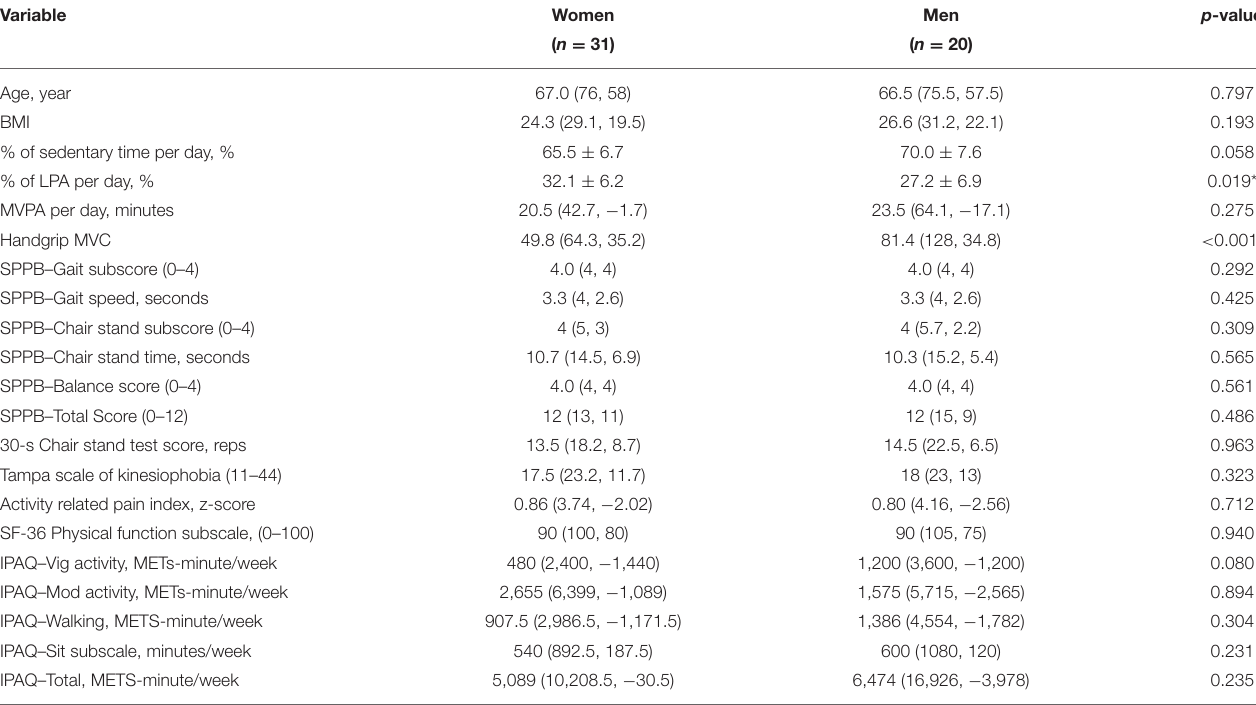
TABLE 1 | Descriptive statistics for primary study measures in male and female participants.